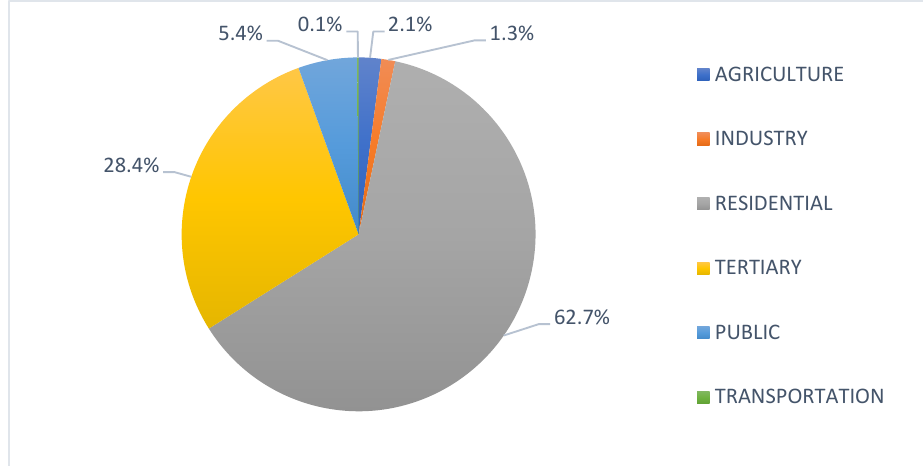
Figure 2. Time structure used for the model.